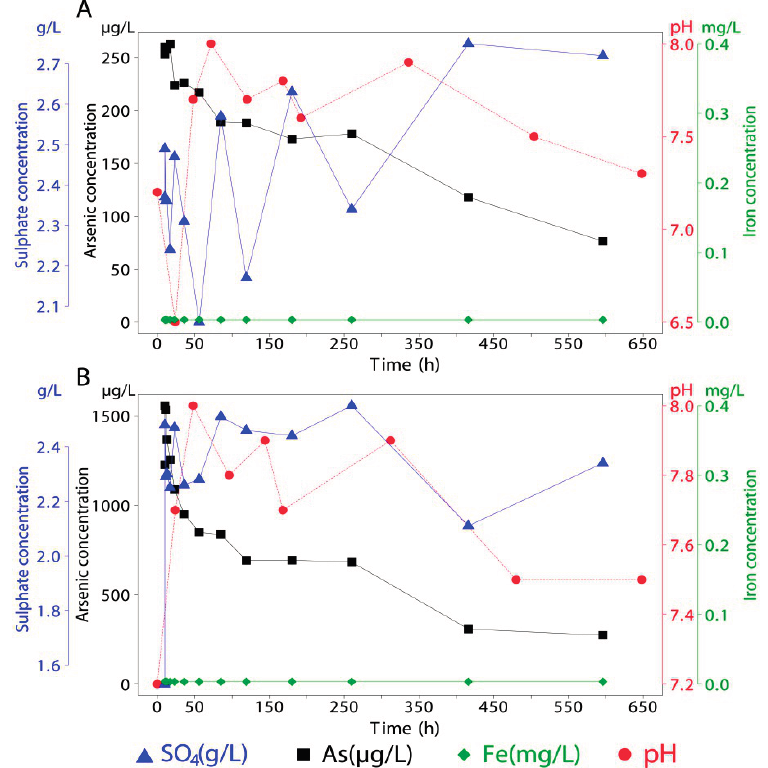
Figure 4. Arsenic release from ferrihydrite. ( A ) Arsenic release from co-precipitated ferrihydrite and ( B ) arsenic release from adsorbed